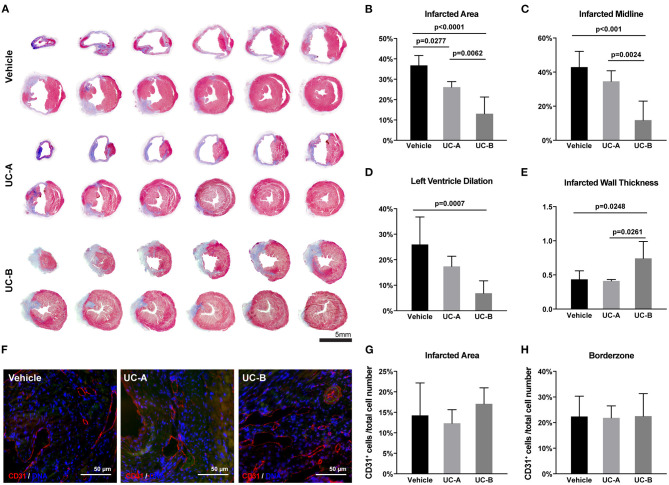
UC-B and, at less extent UC-A, decrease cardiac remodeling 12 weeks after MI. (A) Representative transverse histological sections of hearts stained with Masson's Trichrome of each group. Collagen deposition (scarring) is identified in blue. (B) Left ventricular (LV) infarcted area, (C) infarcted midline, and (D) LV lumen dilation were quantified using the MIQuant Software. (E) Infarcted wall thickness (mm). (F) Representative immunofluorescence images of CD31 detection in the infarcted tissue (autofluorescence in green). (G) Percentage of CD31-expressing cells in the infarcted area and (H) borderzone. Each point represents the mean of the quantification for multiple 300 μm apart sections per heart.